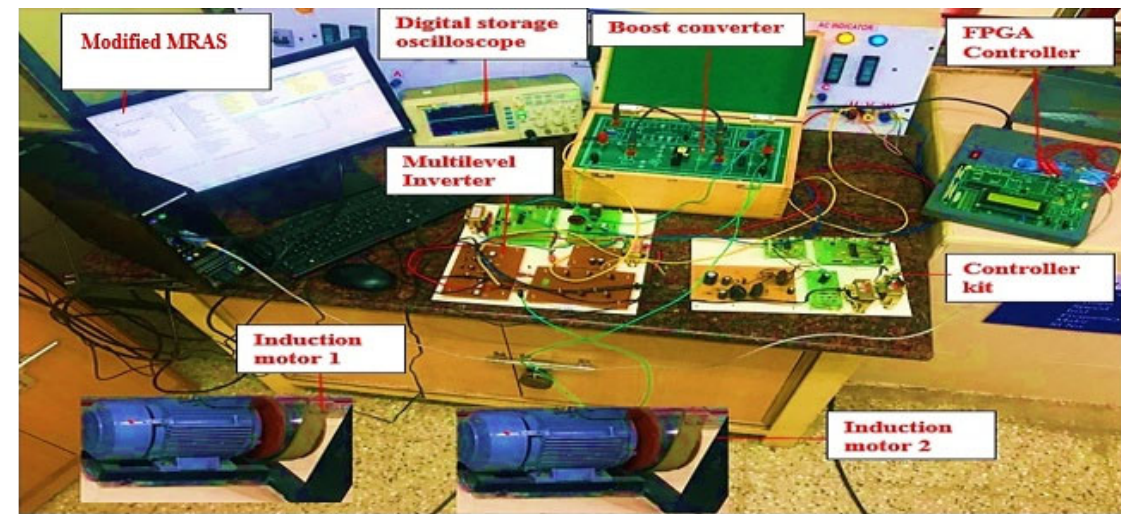
Figure 25. CBC of modified ANN ‐ based sensorless induction motor with NPC inverter. Figure 26. CBC of modified ANN ‐ based sensorless induction motor with cascaded H ‐ bridge in ‐ verter.